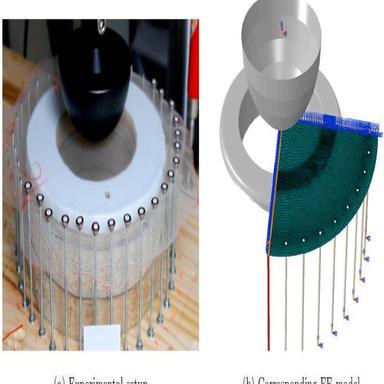
Experimental setup of the plunger experiment allowing to measure fixation forces (a) and corresponding quarter FE model (b).